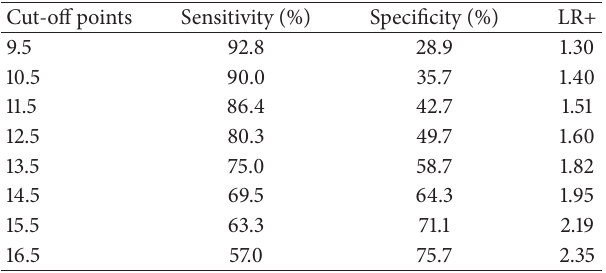
Table 3: Alternative cut-off points for the McMonnies question-